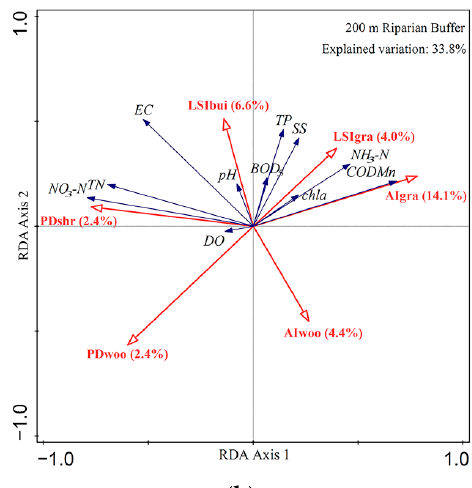
Table 2. Significant explanatory variables screened out by stepwise regression analysis. Scales Explanatory Variables